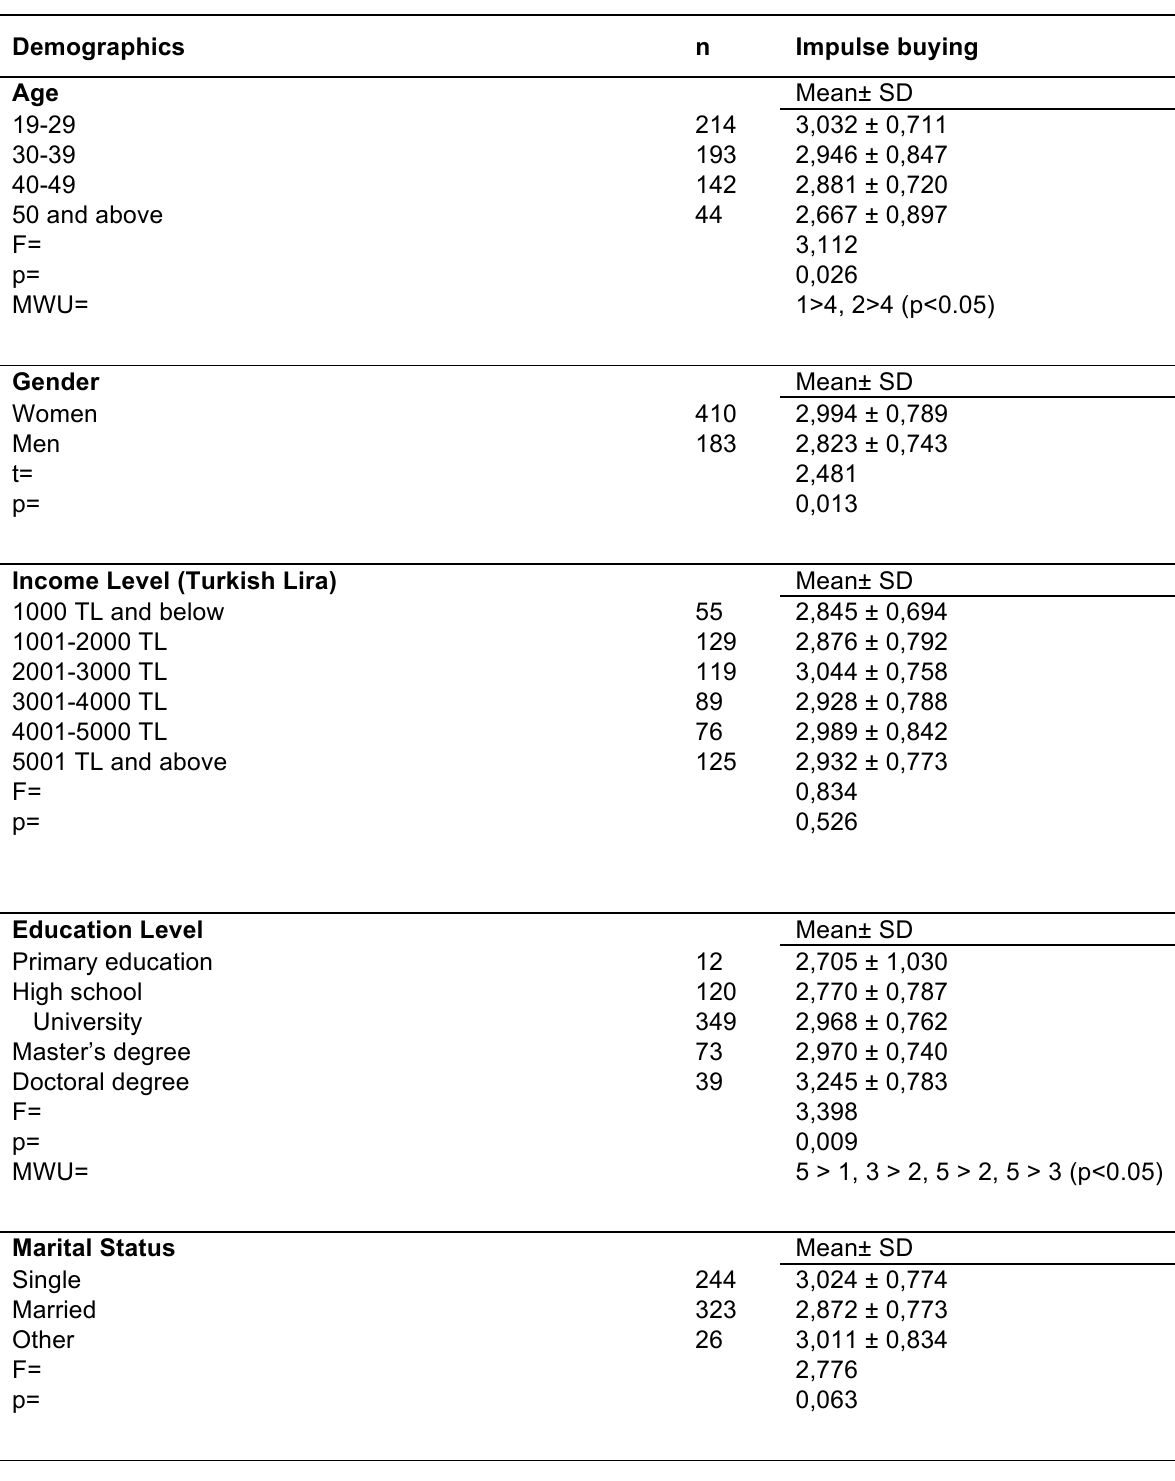
Table 2: t-test and